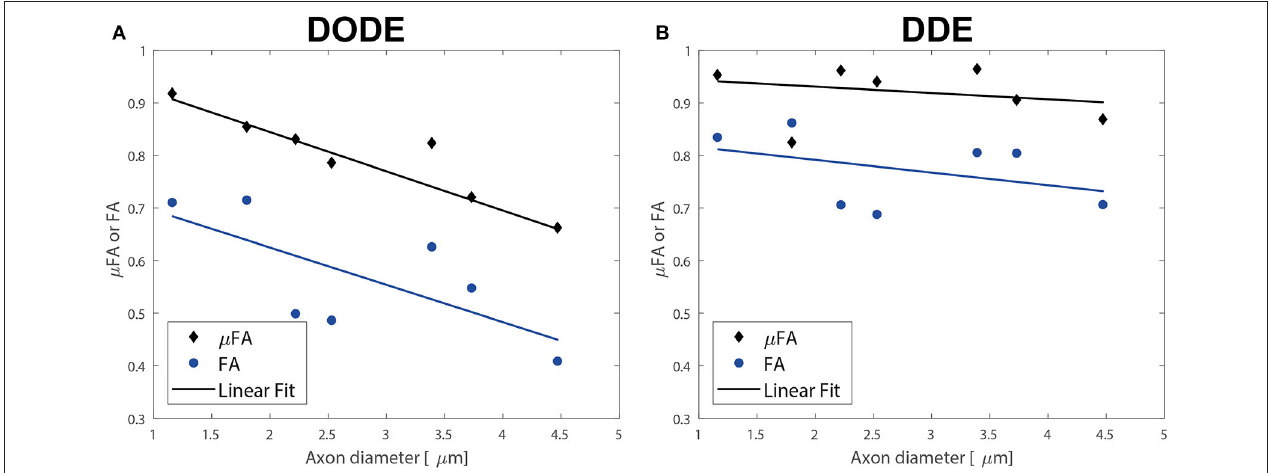
FIGURE 8 | Correlations of diffusion metrics with literature-based average axon diameters in the different white matter tracts. (A) Correlations of metrics derived from DODE. (B) Correlations derived from DDE. The best linear regressions to the experimental data are also given as solid lines. Note the excellent inverse agreement between µ FA DODE and axon diameter, which also had a very high anticorrelation coefficient of ρ ∼− 0.96 while all other metrics did not show significant correlations.